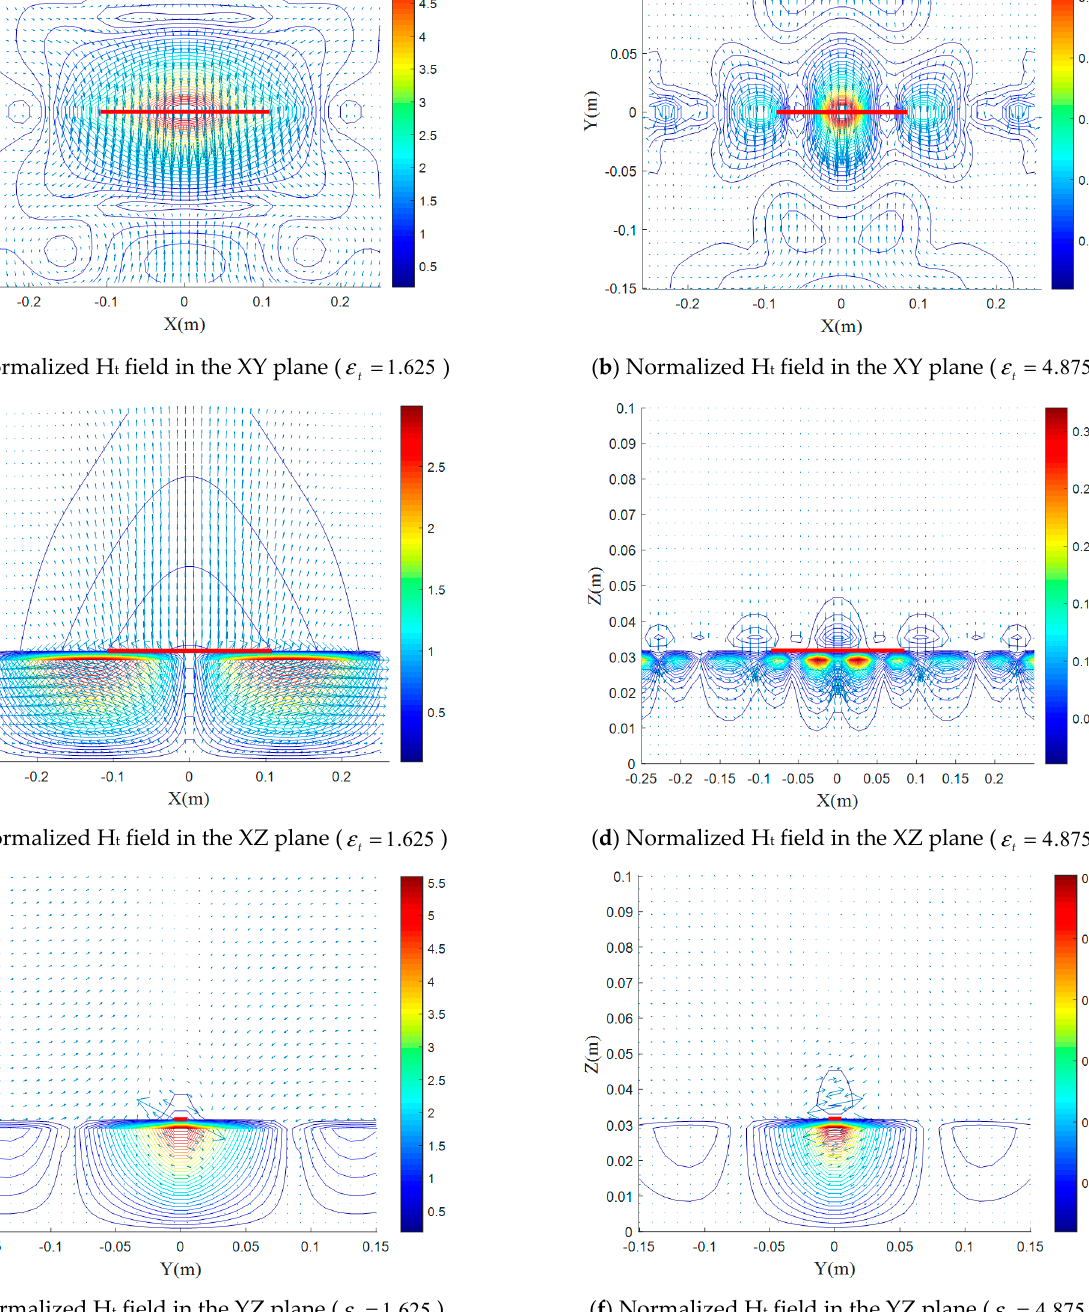
ε with 253 . = ε , 1 = μ and 1 = μ in t z z t